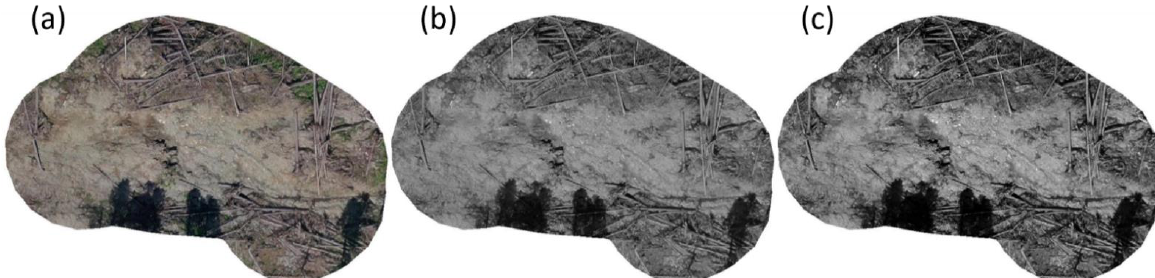
Figure 6. Automated image preparation of exemplary sample site Frohn_02: ( a ) RGB image; ( b ) greyscale image obtained via linear approximation to the luminance; and ( c ) optimized greyscale image after piecewise affine histogram equalization and exposure normalization.